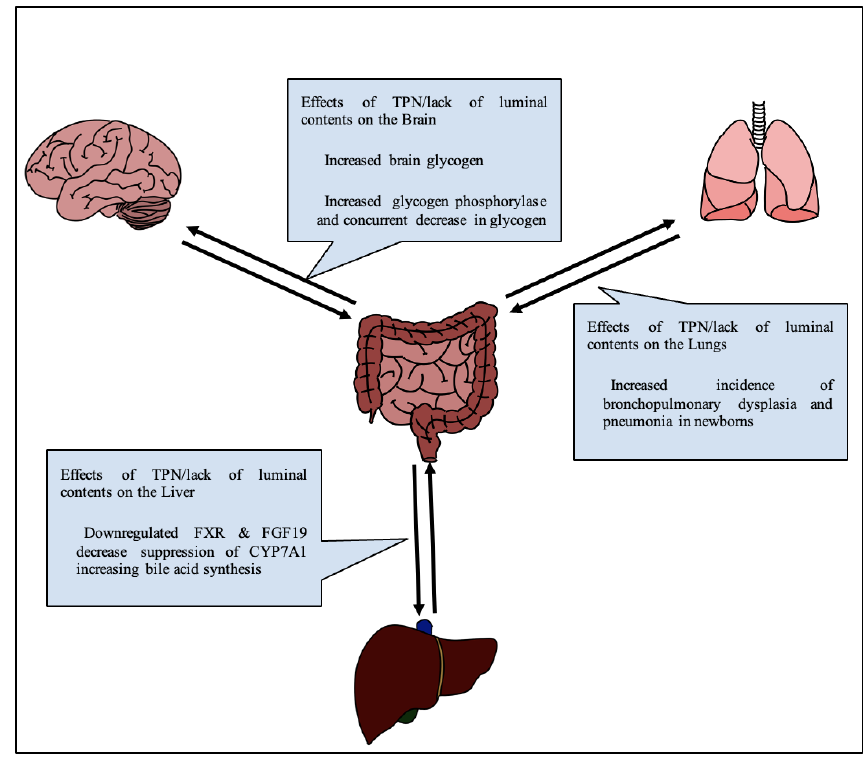
Figure 2. Generalized diagram of effects of TPN on various gut-organ axes.